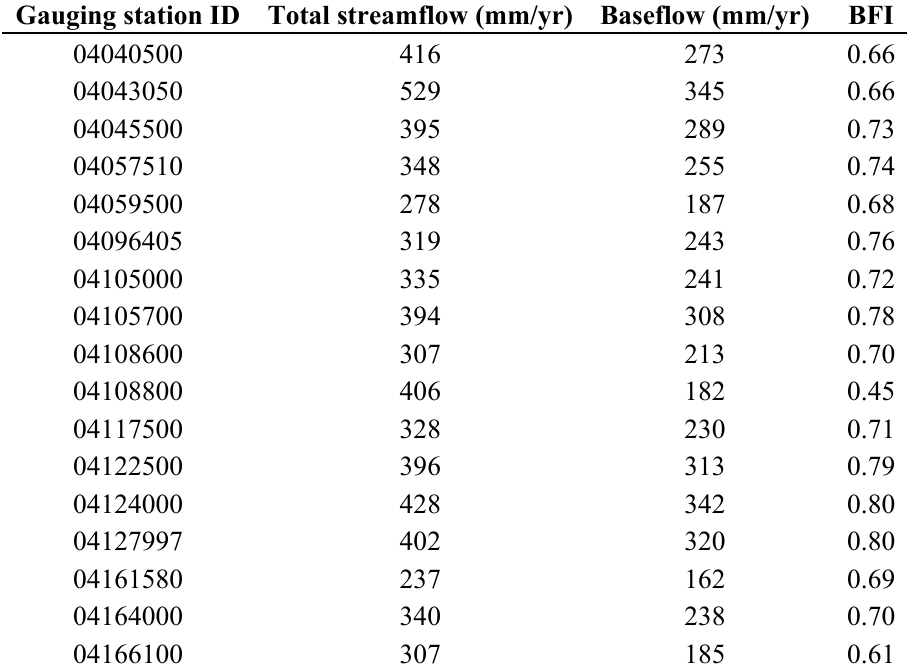
Table 5. Average annual baseflow for 17 watersheds in